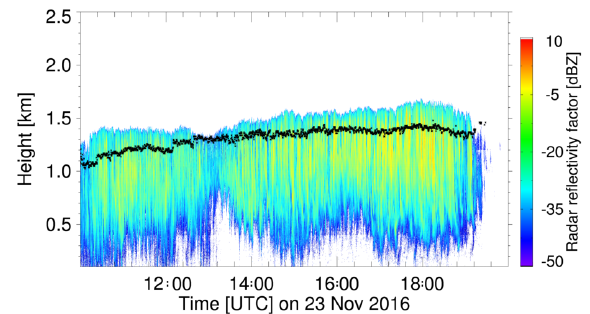
Figure 3. Time–height series of the cloud radar reflectivity fac- tor on 23 November 2016 between 10:00 and 20:00UTC at Ny- Ålesund. Black dots indicate the cloud base height from ceilometer